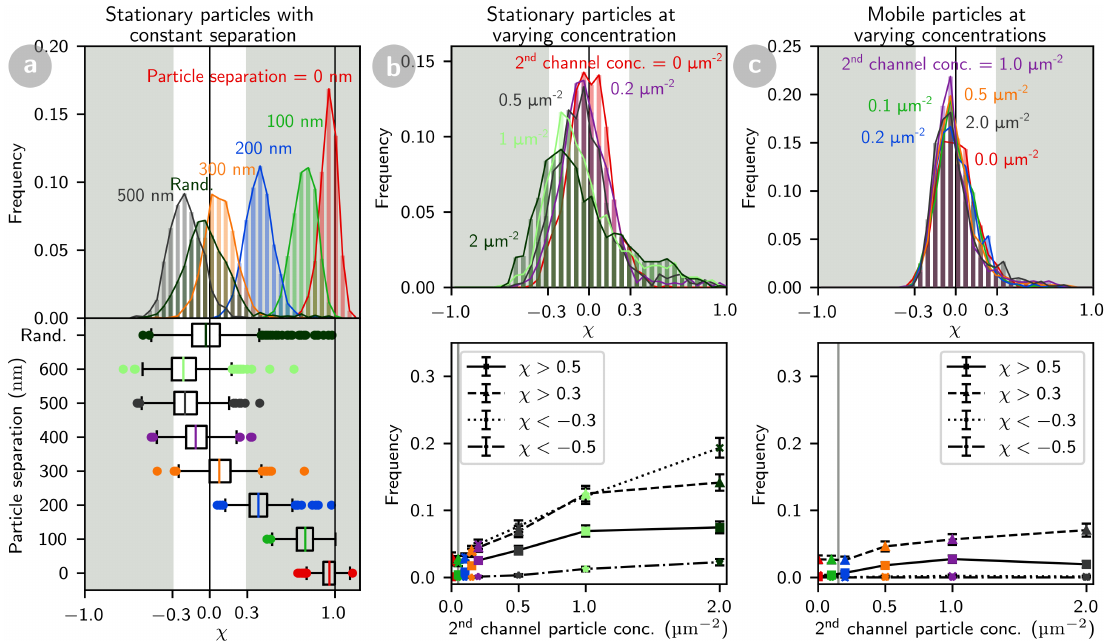
Figure 5. Distribution of particle cross-correlation coefficients obtained for simulated two-channel confocal images. ( a ) Particle cross-correlation distribution for particles separated by a fixed distance ∆ r . ( b , c ) Effect of increasing the particle concentration in the second channel for randomly placed particles, either stationary ( b ) or mobile ( c ). The lower panels in ( b , c ) give the frequency of accidentally correlated ( χ > 0.3 and χ > 0.5) and anti-correlated ( χ < − 0.3 and χ < − 0.5) events. All distributions show the cross-correlation of the particles detected in the green channel. Grey vertical lines in ( b , c ) lower panels indicate the experimental